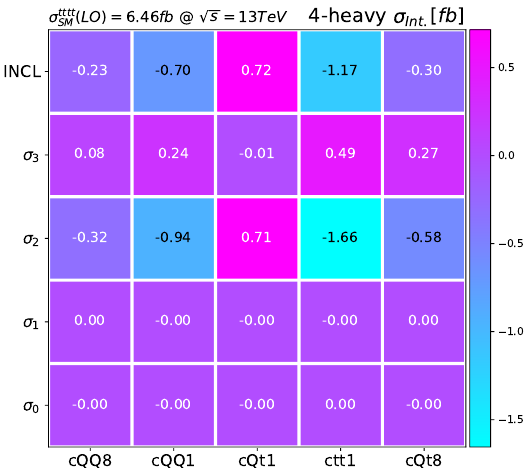
Figure 4 . Depiction of the interference strength of the 4-heavy operators. The columns denote the WCs in their UFO notation. The top row shows the total inclusive predictions, i.e. summing all the QCD and EW-induced contributions. Each of the subsequent rows indicates the summation of all terms at a given order of α s (an example is given in the main text). The predictions are obtained √ at c = 1 , s = 13 TeV, and Λ = 1 TeV. The SM LO cross-section at reference.